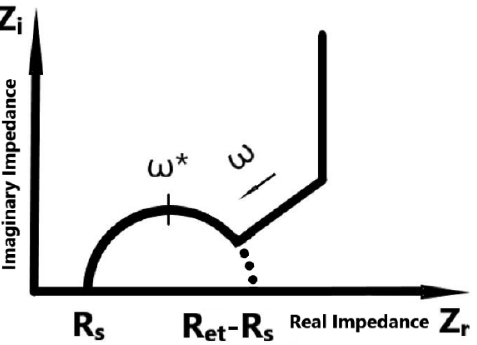
Figure 1. An ideal Nyquist curve of dielectric materials. The frequency ω increases following the arrow direction. ω* indicates the frequency at highest point of the semicircle. Figure 2. The equivalent circuit model of the ideal Nyquist curve.